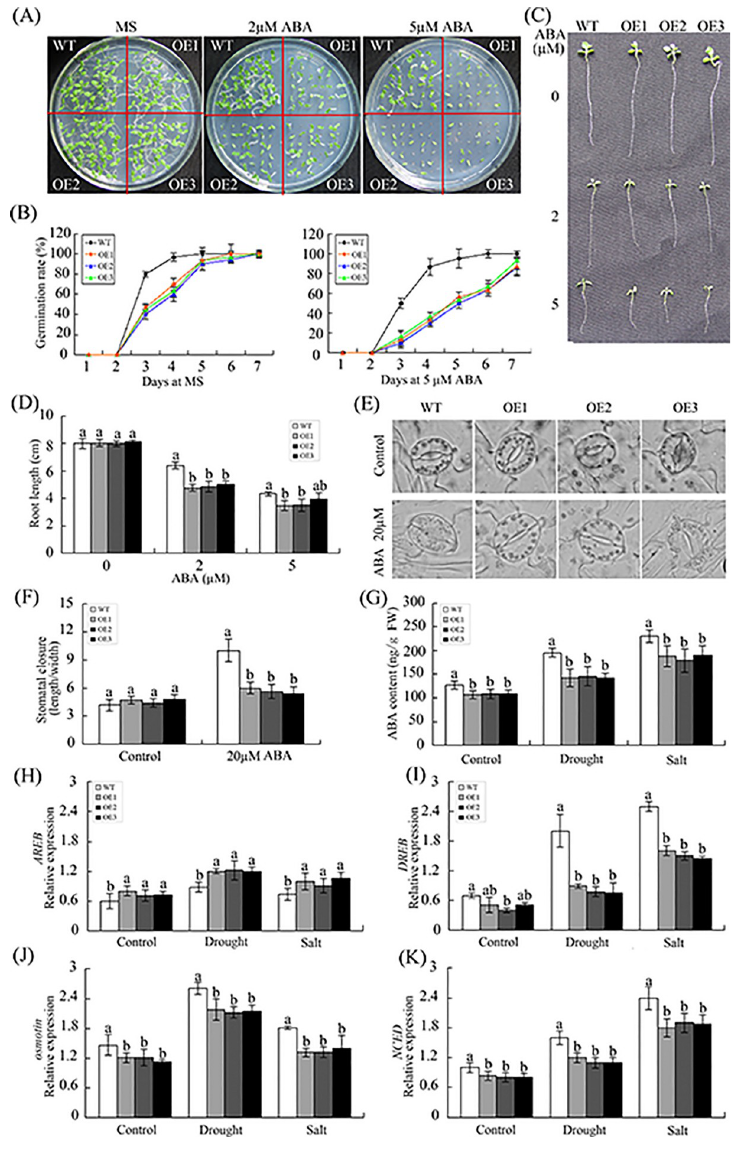
Fig 7. Overexpression of GhWRKY68 negatively regulates ABA signalling in transgenic plants. (A) Seed germination of WT and OE lines on 1/2 MS medium containing different ABA concentrations (0, 2 or 5 μ M). (B) Germination rates of the WT and OE lines under 0 or 5 μ M ABA treatment conditions. Germination was scored daily. (C) Root elongation of WT and OE plants after treatment with different ABA concentrations (0, 2 or 5 μ M). (D) Statistical analysis of the root length. (E) Micrographs showing the stomatal closure of transgenic and WT plants with or without 20 μ M ABA treatment. (F) Stomatal closure response to ABA treatment. The data represent the means ± SE of 40 stomata from three independent experiments. (G) ABA contents of WT and OE plants before and after treatment. For drought treatment, 8-week-old OE and WT plants were grown in soil without water for 10 days. For salt treatment, WT and OE plants were irrigated with salt water (200 mM) for 1 month. The values represent the means ± SE of three independent experiments. The different letters above the columns indicate significant differences ( P < 0.05) according to Duncan’s multiple range